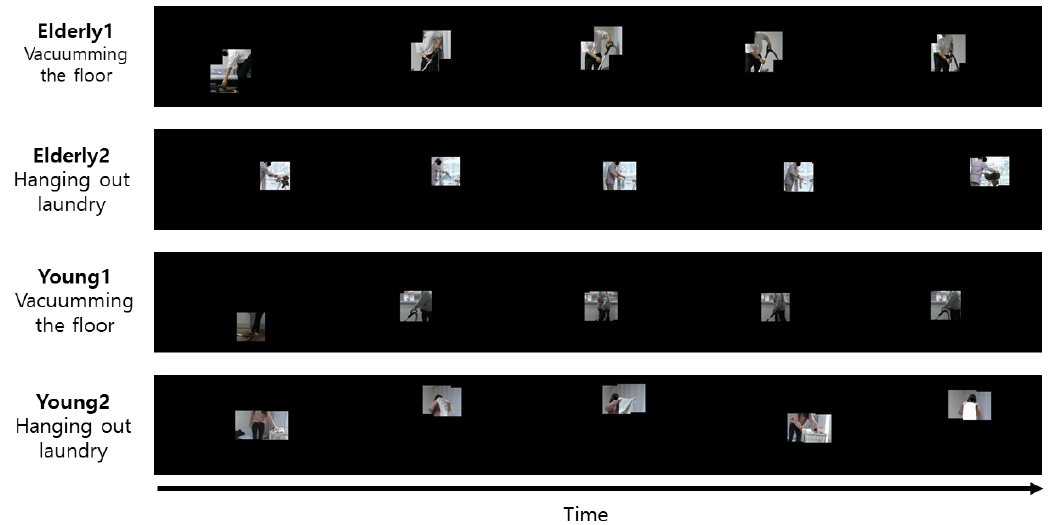
Figure 20. Example of hand–object ROI video with only the hand–object left and the background removed. Table 3. ROI-based behavior recognition accuracy (CS).